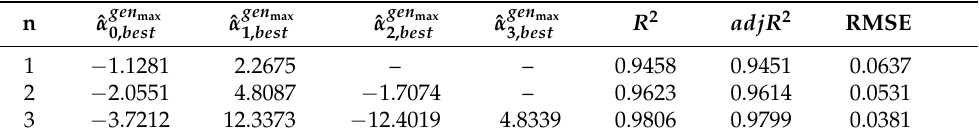
Table 1. The best parameter estimates given by the MLFF-PE algorithm for different orders n . n ˆ α gen max 0,